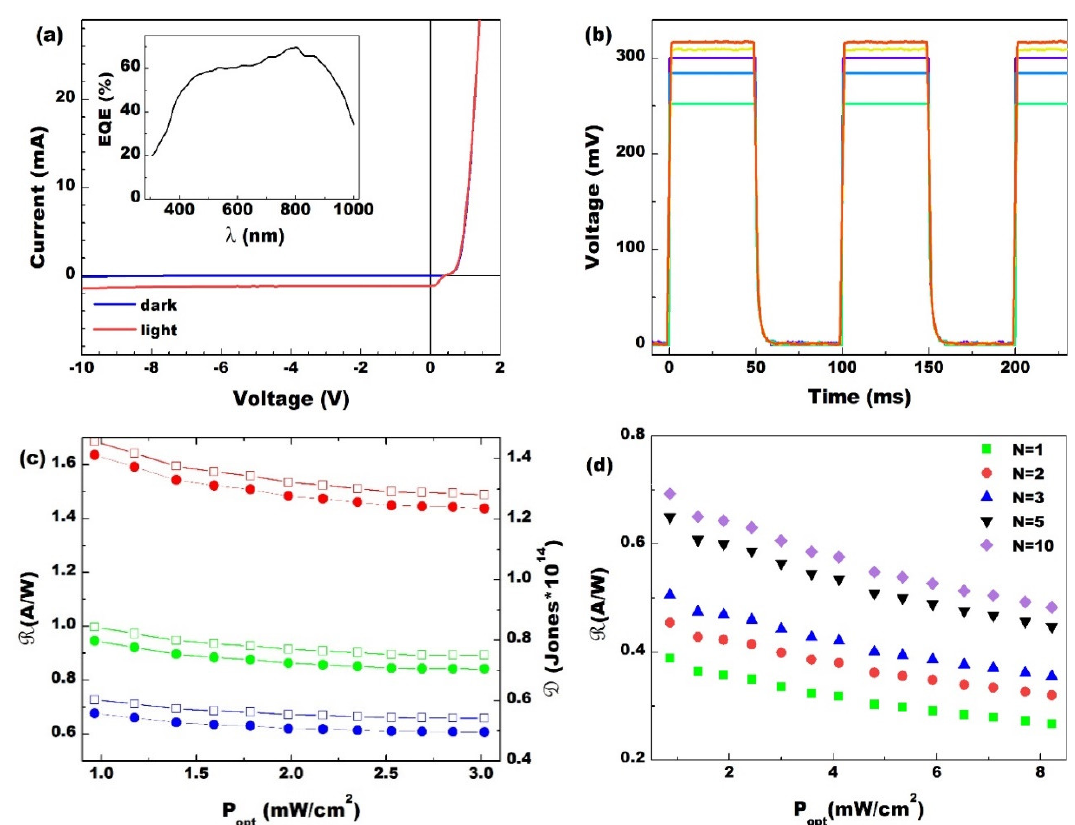
Figure 2. ( a ) Current versus voltage characteristics acquired in dark conditions (dark) and under illumination (light). Inset: typical external quantum efficiency of n-silicon heterojunction (NSH) photodetector (PD) sample; ( b ) PD response under dark and light conditions (frequency 10 Hz) when the junction is lightened with different LED light power (green curve: 1.4 mW/cm 2 ; turquoise curve: 1.8 mW/cm 2 ; violet curve: 2.2 mW/cm 2 ; yellow curve: 2.5 mW/cm 2 ; red curve: 2.8 mW/cm 2 ); ( c ) responsivity (closed symbols, left axis) and detectivity (open symbols, right axis) of the three different samples with different optical transmittance at λ = 550 nm T = 63% for red symbols, T = 44% for green symbols, and T = 42% for blue symbols; ( d ) responsivity as a function of P opt for PDs with different numbers of fingers N. Here the SWCNT film optical transmittance at λ = 550 nm is T = 49%. Data reported in ( a - c ) have been adapted from [19] and those in ( d ) from [20].